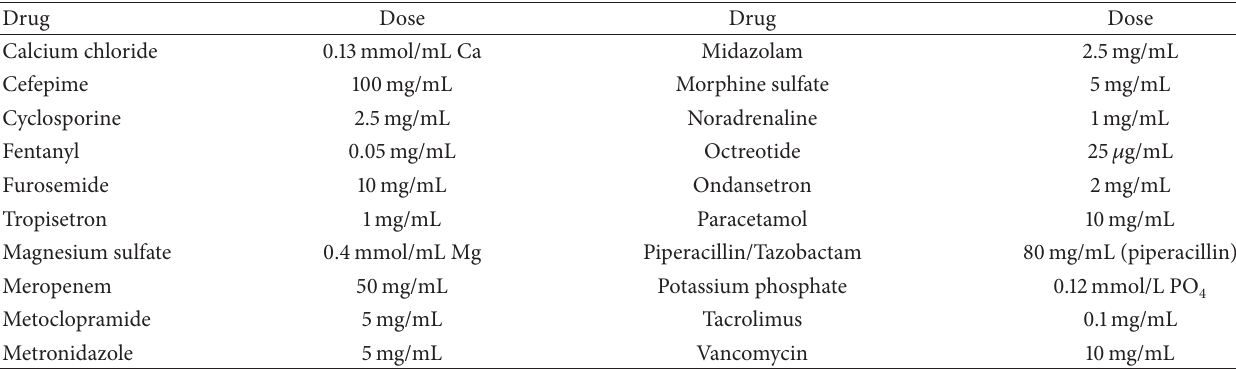
Table 6: Drugs compatible with NuTRIflex Lipid Special after 1 hour contact mixed in 1:1 (v/v) proportions